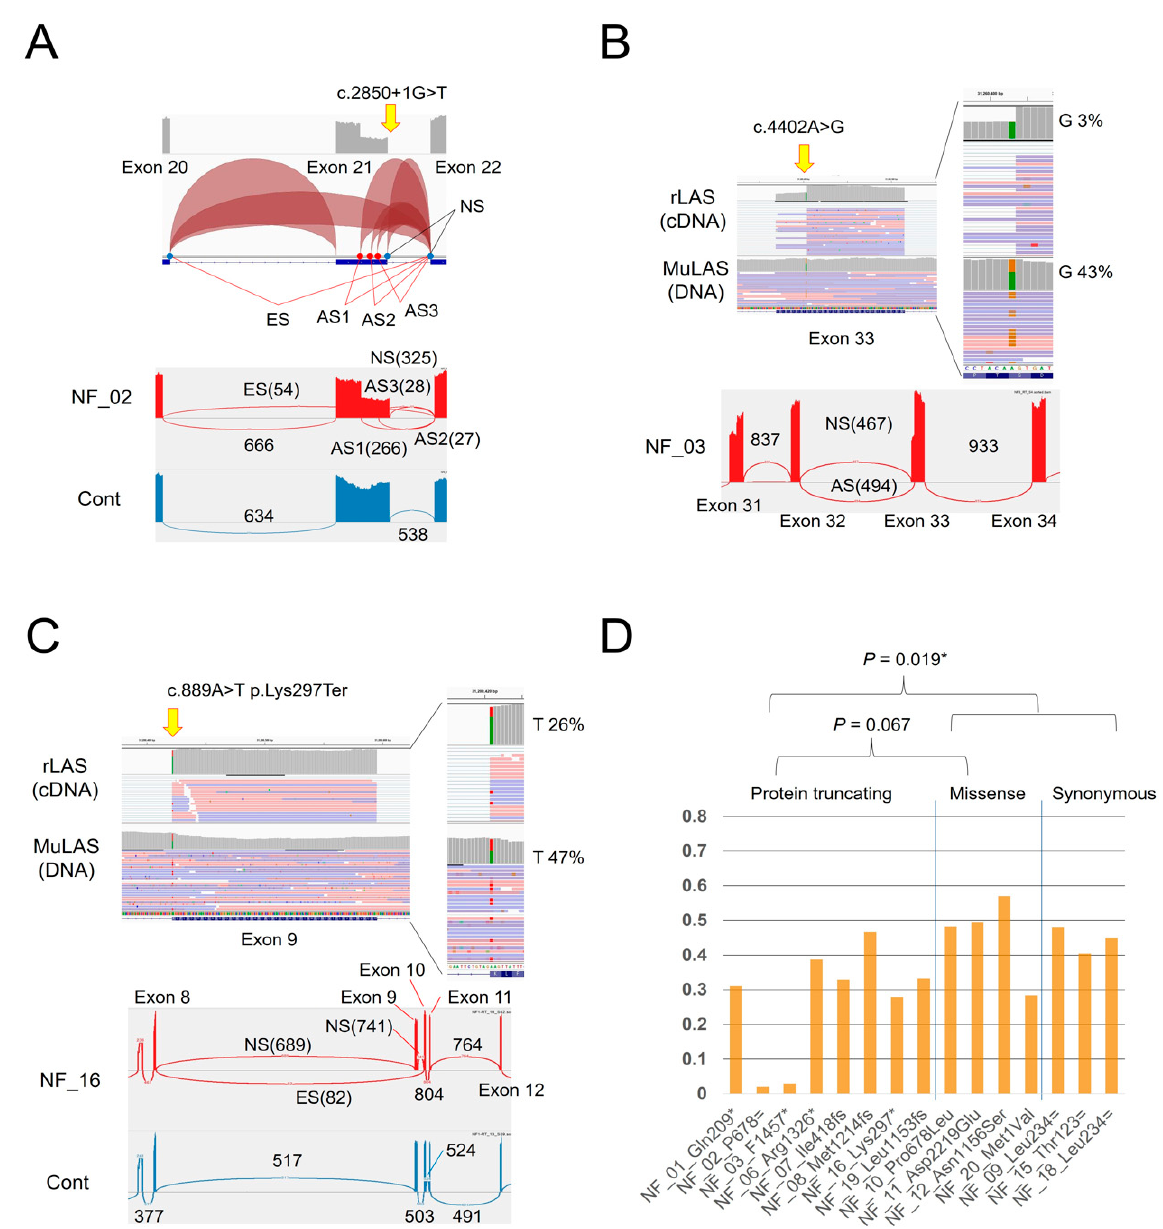
Figure 4. NF1 splicing analysis by rLAS. ( A ) The NF_02 exon 21 splicing donor site mutation showed three different aberrant splicings and exon 21 skipping. The splice junction track (upper) and sashimi plot (lower) of IGV are shown. ( B ) In NF_03, this similar look to missense mutation actually causes abnormal splicing, creating a new splicing acceptor site. The IGV coverage track, alignment track, and sashimi plot are shown. ( C ) NF_16 missense substitution is the first base of exon 9, and it causes exon 9 skipping in minor populations. ( D ) Mutation allele expression ratio. AS, aberrant splicing; ES, exon skipping; and NS, normal splicing. Numbers in the sashimi plot indicate the junction read numbers.